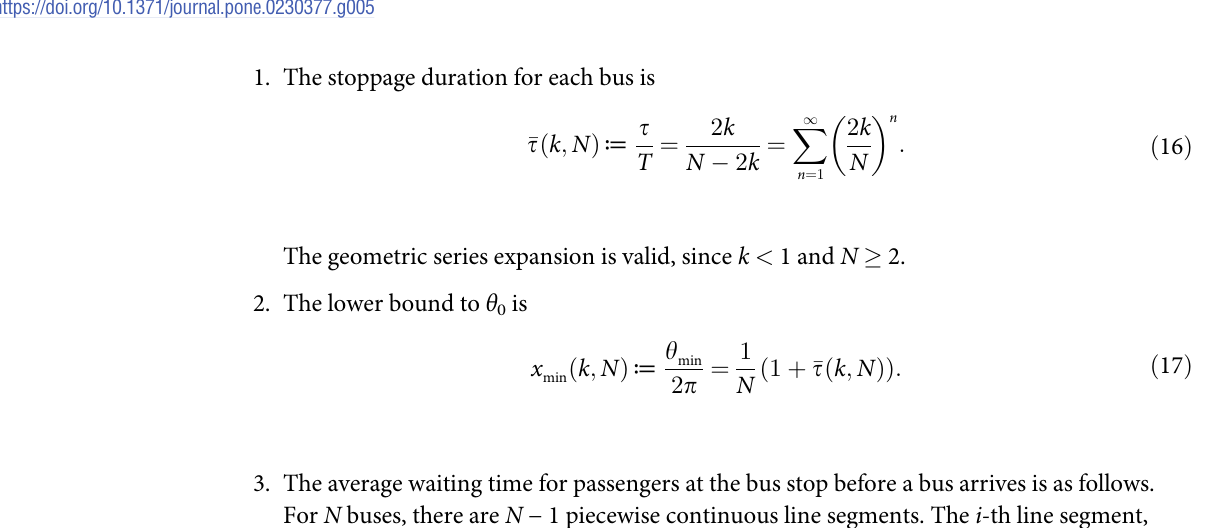
Fig 5. Graph of θ min versus k